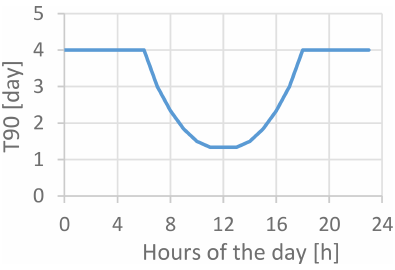
Figure 6. Calibrated E. coli decay